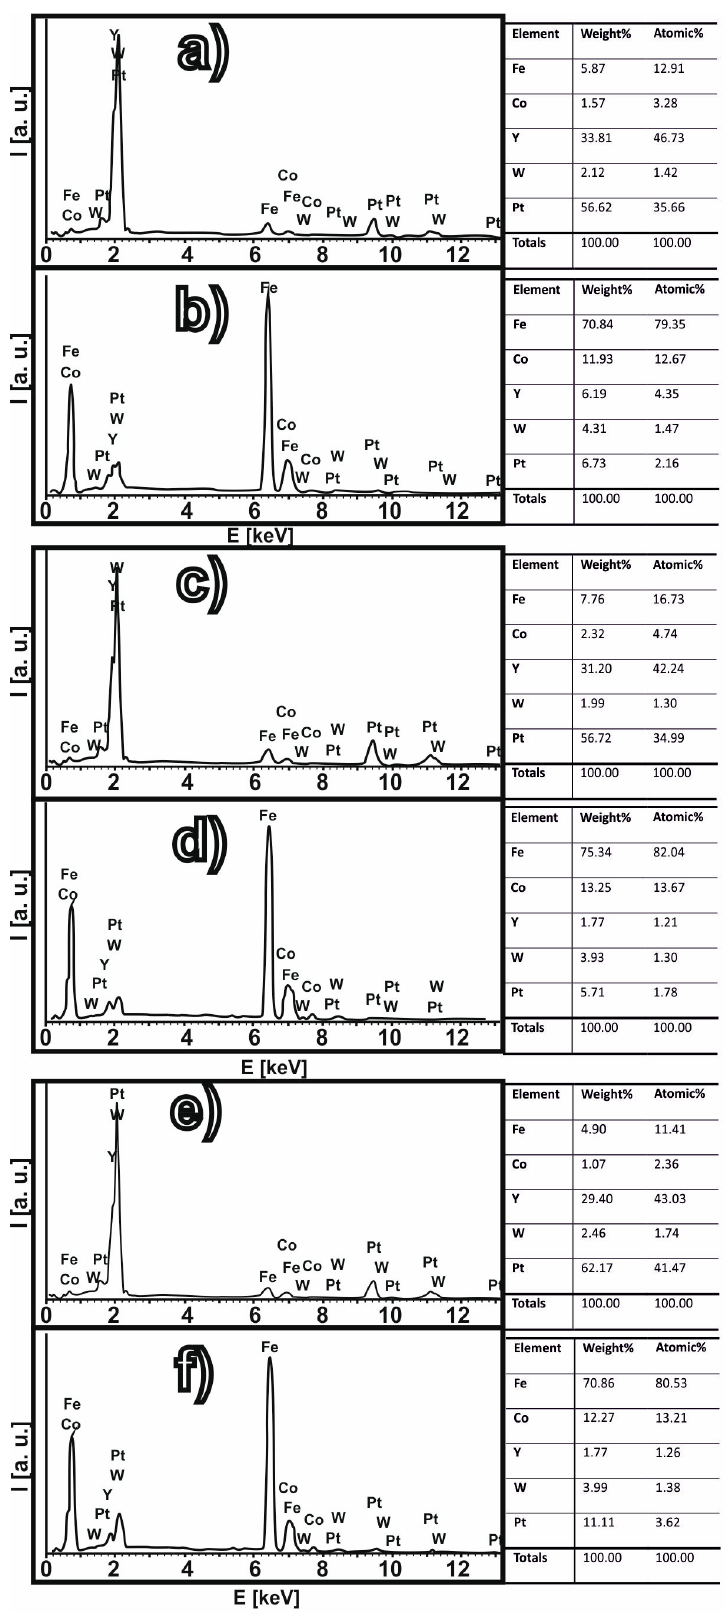
Figure 5. EDS results obtainedfor the investigated alloys, in selected areas of measurement: ( a , b ) Fe 61 Co 10 B 20 Y 5 W 1 Pt 3 ; ( c , d ) Fe 61 Co 10 B 20 Y 4 W 1 Pt 4 ; ( e , f ) Fe 61 Co 10 B 20 Y 3 W 1 Pt 5